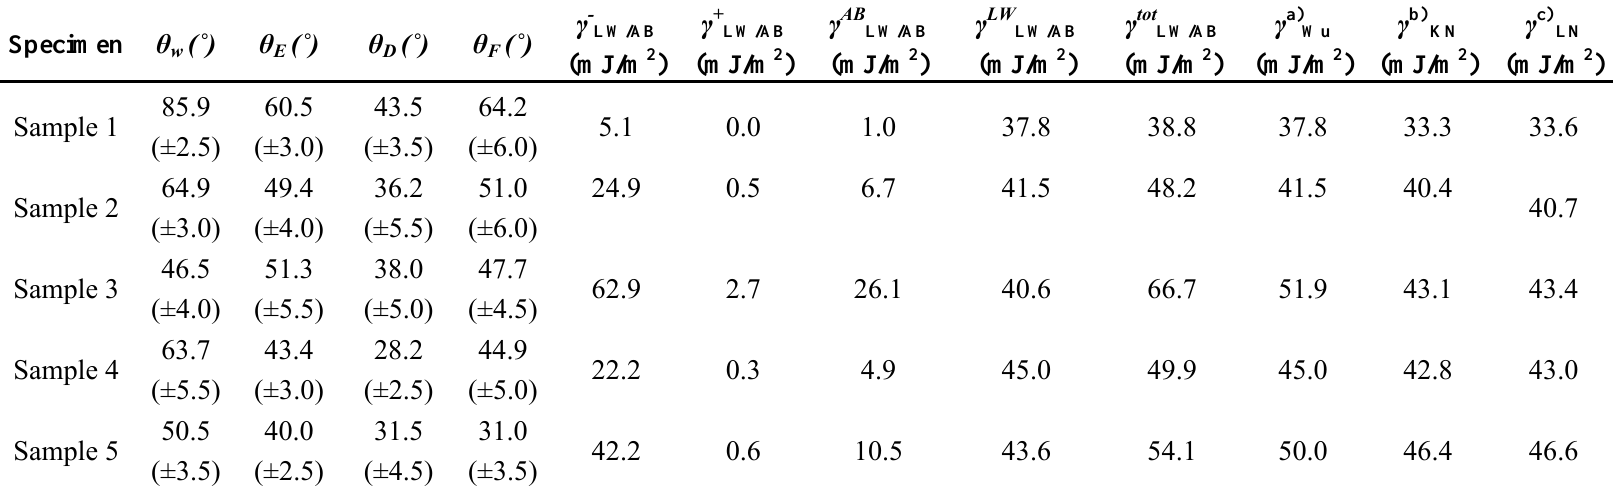
Table 1. Contact angle analysis results of different specimens using deionized water (w), ethylene glycol (E), diiodomethane (D), and formamide (F) as wetting agents. Sample 1: pristine/control; Sample 2: plasma treated: Sample 3: PAA grafted; Sample 4: chitosan coated; Sample 5: chitosan/pectin coated (mean± standard